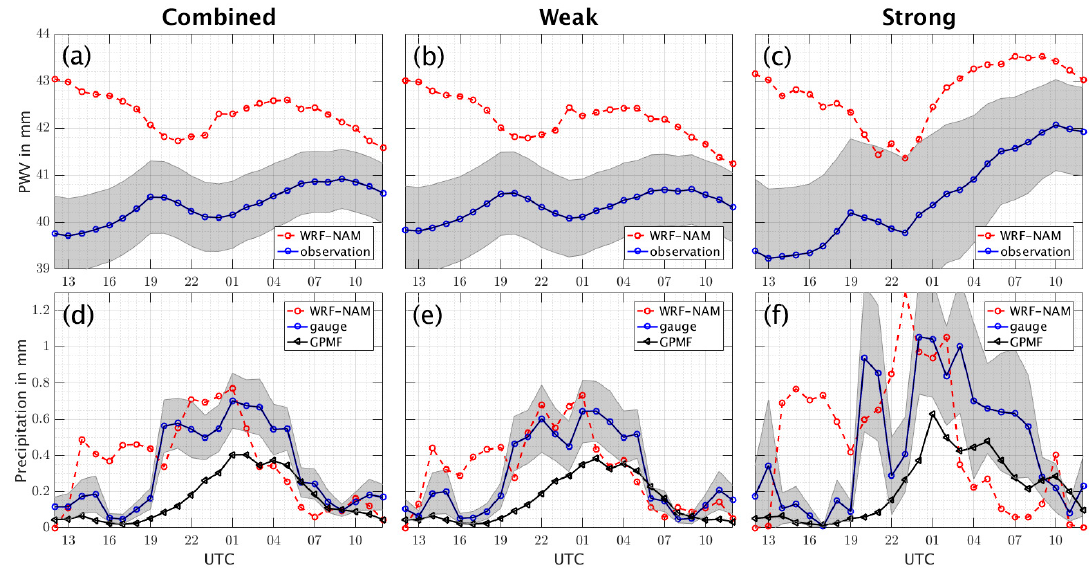
Figure 4. Mean diurnal cycle of WRF-NAM PWV and GPS-derived PWV (or observations) across 14 stations for combined strongly-weakly forced days ( a ), weakly forced days ( b ), and strongly forced days ( c ). Mean diurnal cycle of precipitation across 14 stations, based on WRF-NAM simulations, rain gauge measurement, and GPM Final product for combined strongly–weakly forced days ( d ), weakly forced days ( e ), and strongly forced days ( f ). Shaded areas in grey represent standard errors of the observations.